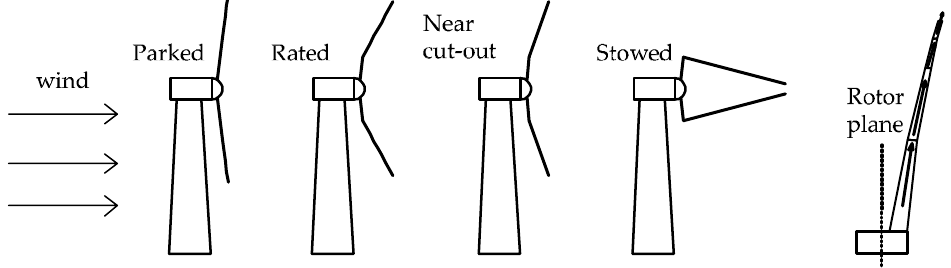
Figure 1. Ultra-light load-aligned concept. Reproduced with permission from [9], AIAA, 2013.